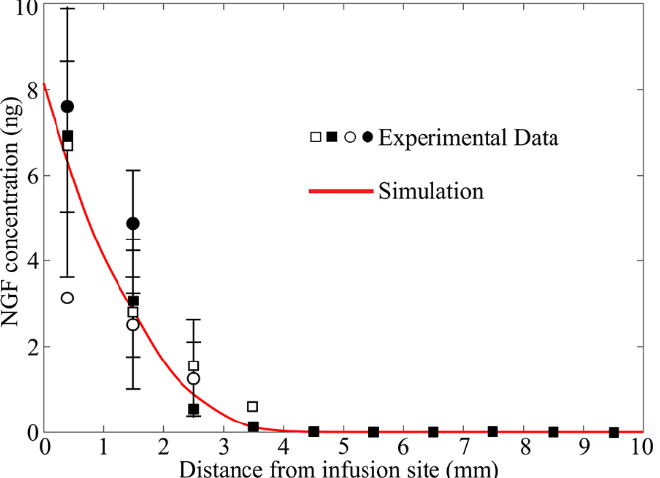
Figure 4. Comparison of experimentally measured and modelling predicted drug concentration upon CED infusion. Experimental data is extracted from Figure 3, left in Ref. [74].